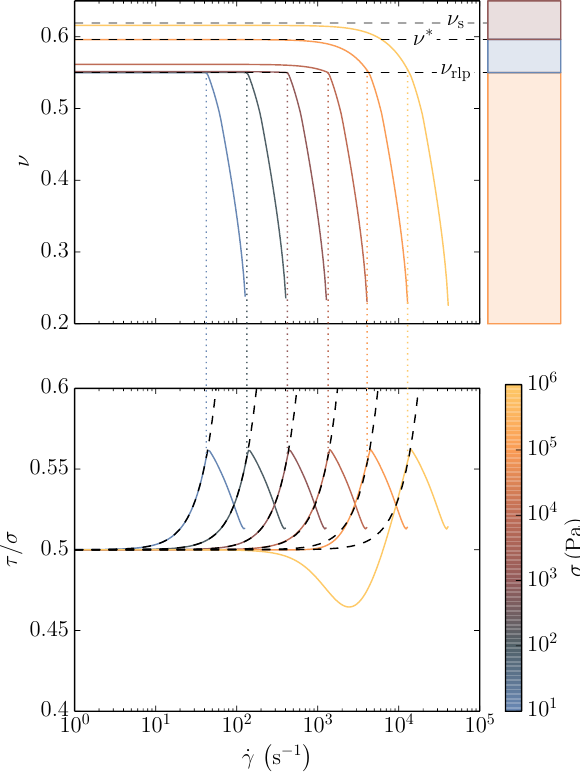
Figure 9. Concentration ν (top) and stress ratio τ/σ (bottom) as proposed by the extended kinetic theory (colored solid lines) in comparison to the simplified relation (black dashed lines in bottom figure) for the idealized quartz sand. The simplified relation for the stress ratio approximates the complex extended kinetic theory good for concentrations between ν rlp and ν ∗ , e.g., in the monotonic dense flow regime (blue area, top-right). Between ν ∗ and ν s the regime is dense but non-monotonic (red area, top-right), below ν rlp the regime is purely collisional (yellow area, top-right) and the concentration decreases rapidly with increasing shear